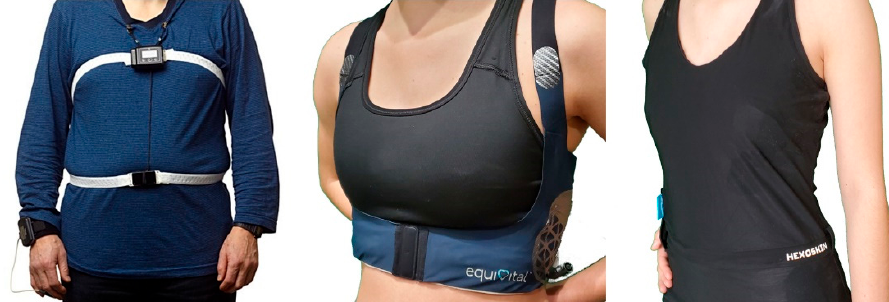
Figure 1. Exemplar WRMs of each type: belt (left), strap (center), and shirt (right). The belt type WRM shown is the Nox T3 with two RIP bands (TC and AB) worn above clothing. The strap type WRM shown is the Equivital EQ02 LifeMonitor, worn alongside a fitness undergarment. The shirt type WRM shown is the Hexoskin Smart Garment, worn directly on the skin. Photo credits: (left) image reproduced with permission of Nox Medical Global, Reykjavík, Iceland; (center) and (right) images taken by Respiratory Technologies Laboratory.